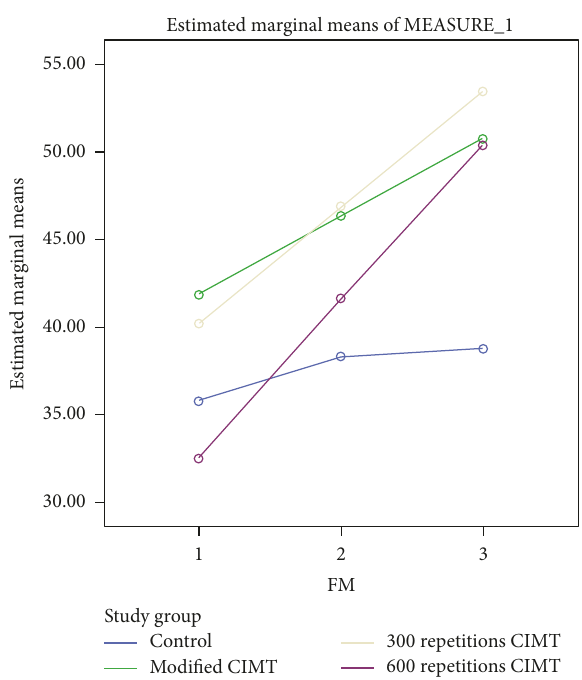
Figure 2: A profile plot showing groups’ mean scores in FM at baseline, 2 weeks, and 4 weeks after